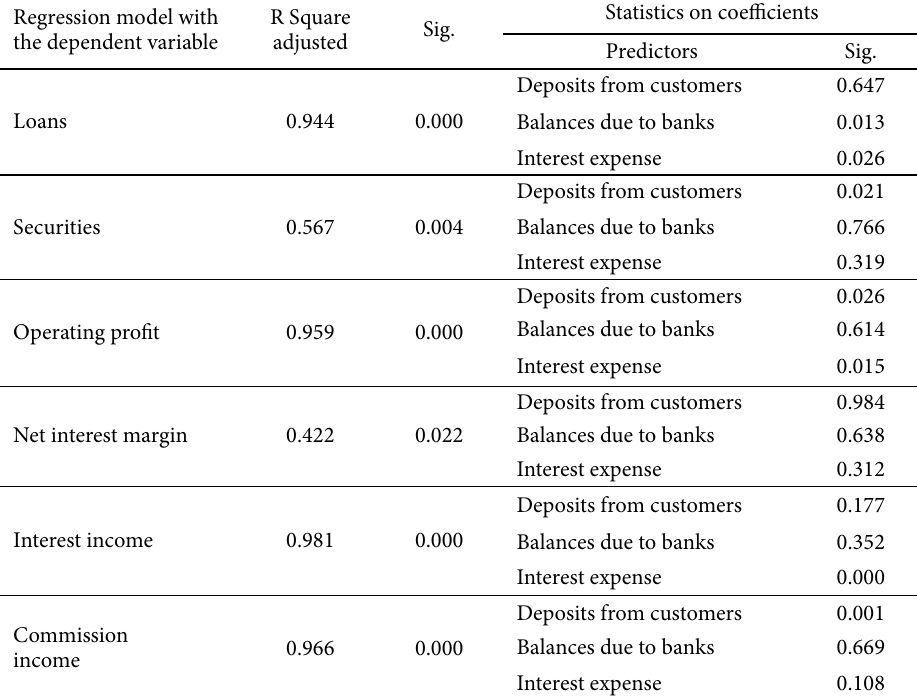
Table 4. Results of the regression analysis: models with different dependent variables Regression model with R Square the dependent variable adjusted